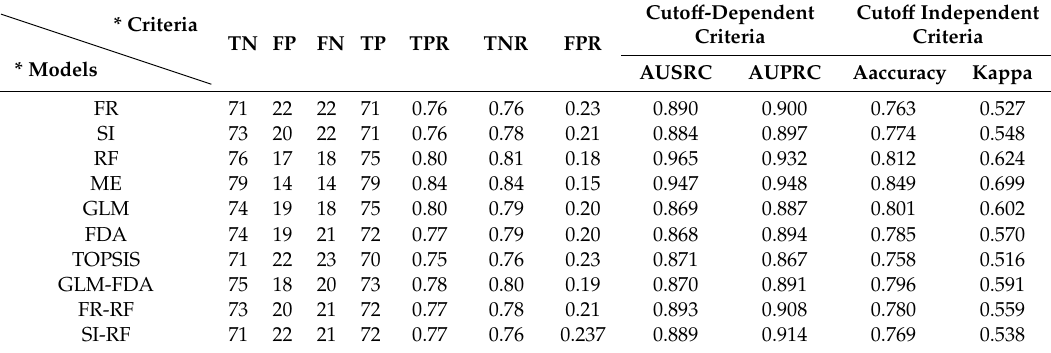
Table5. Validationofgullyerosionsusceptibilitymapsusingcuto ff -dependentandindependentcriteria.